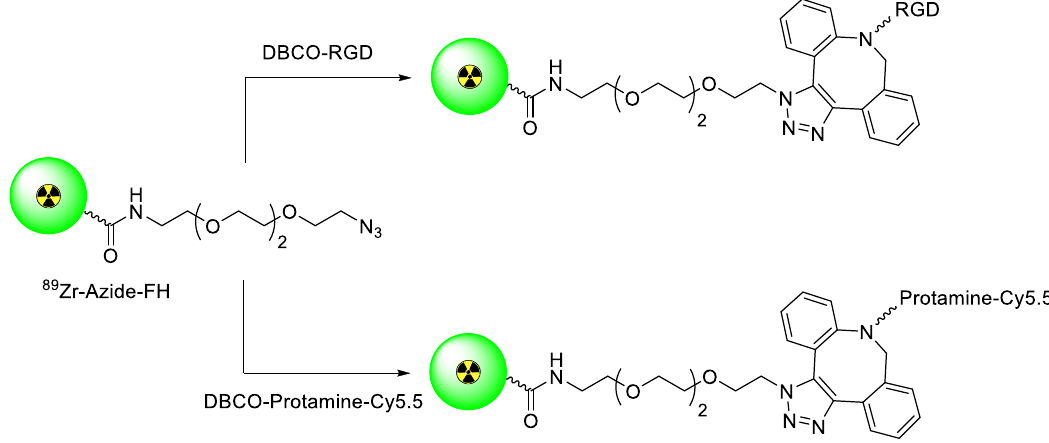
Figure 7. Preparation of 89 Zr-labeled multifunctional nanoprobes using SPAAC ligation.